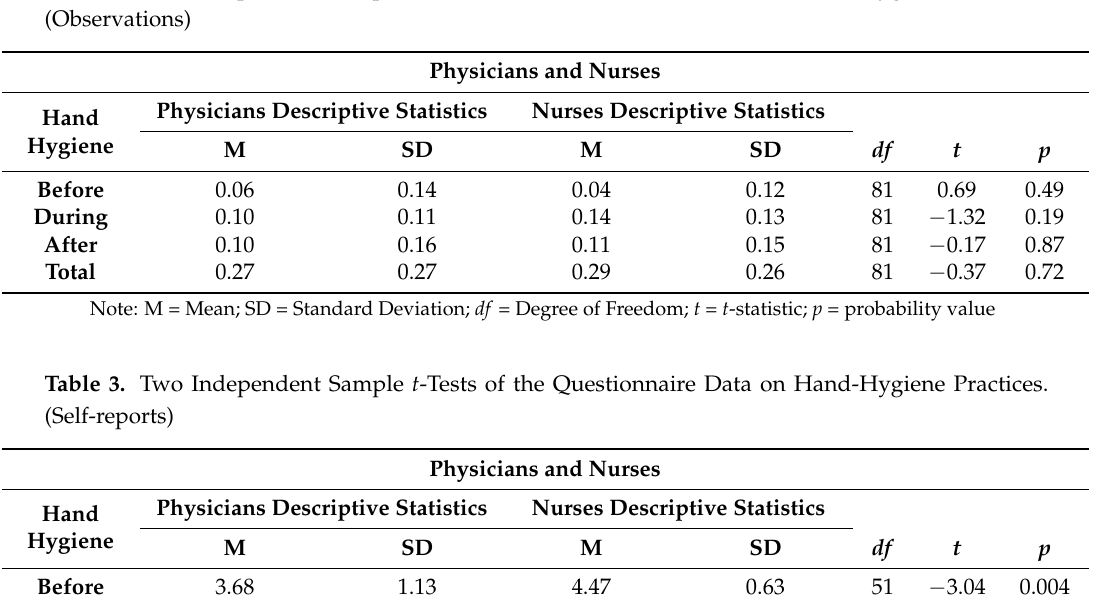
Table 2. Two Independent Sample t -Tests of the Observational Data on Hand-Hygiene Practices.